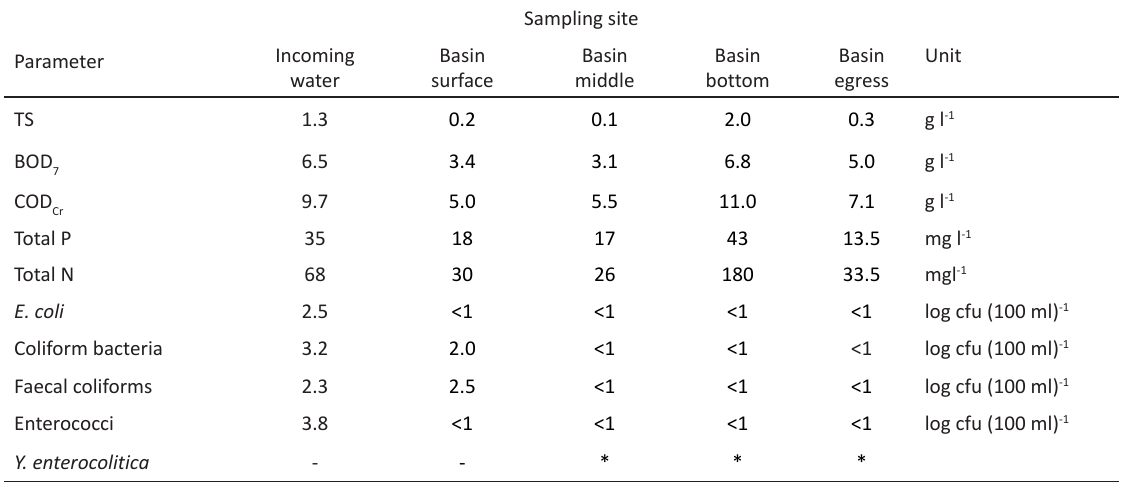
Table 3. The quality of wastewater from carrot peeling (plant B) in a wastewater basin, V = 8000 m 3 . Results are means of two samples.